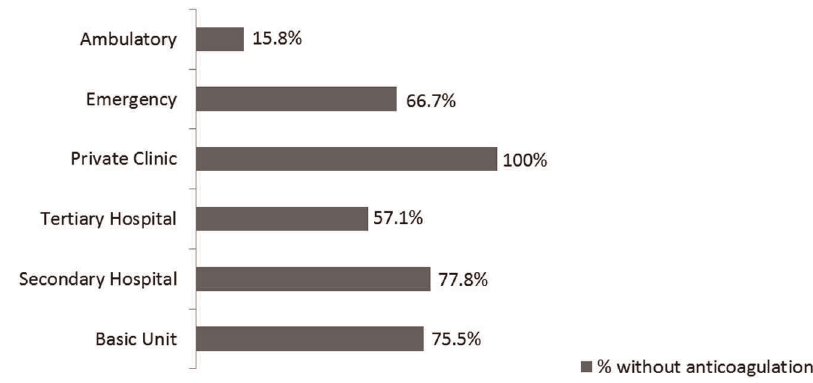
Figure 4 - Percentage of patients without anticoagulation therapy according to the location where the ECG